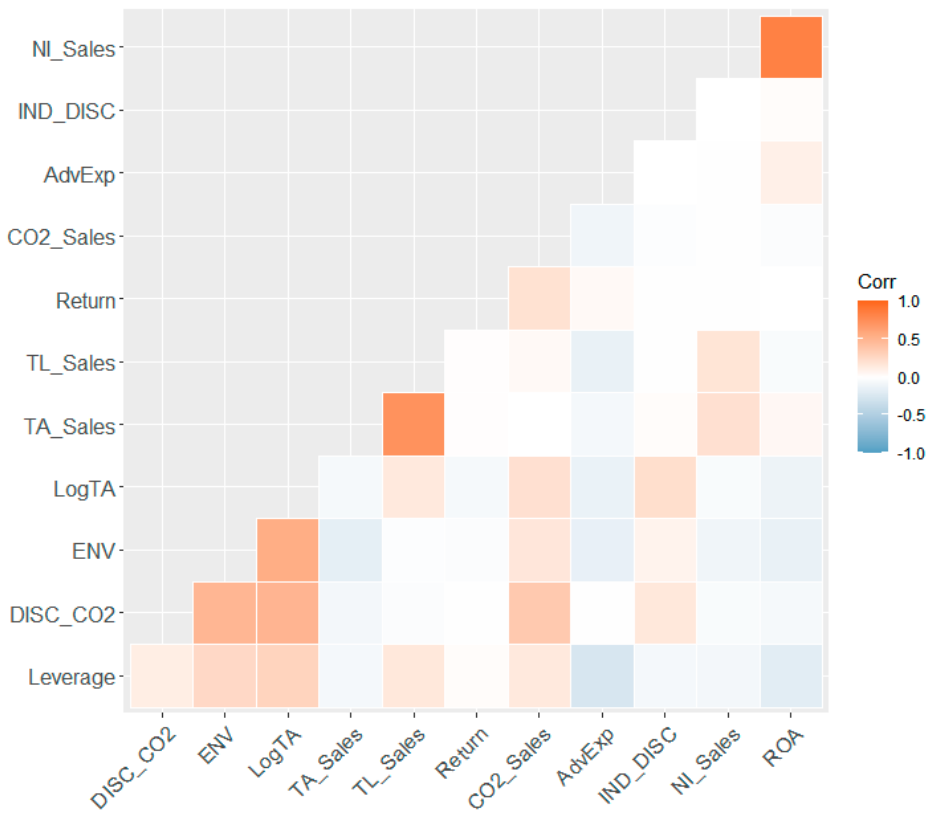
Figure 1. Correlation for variables.